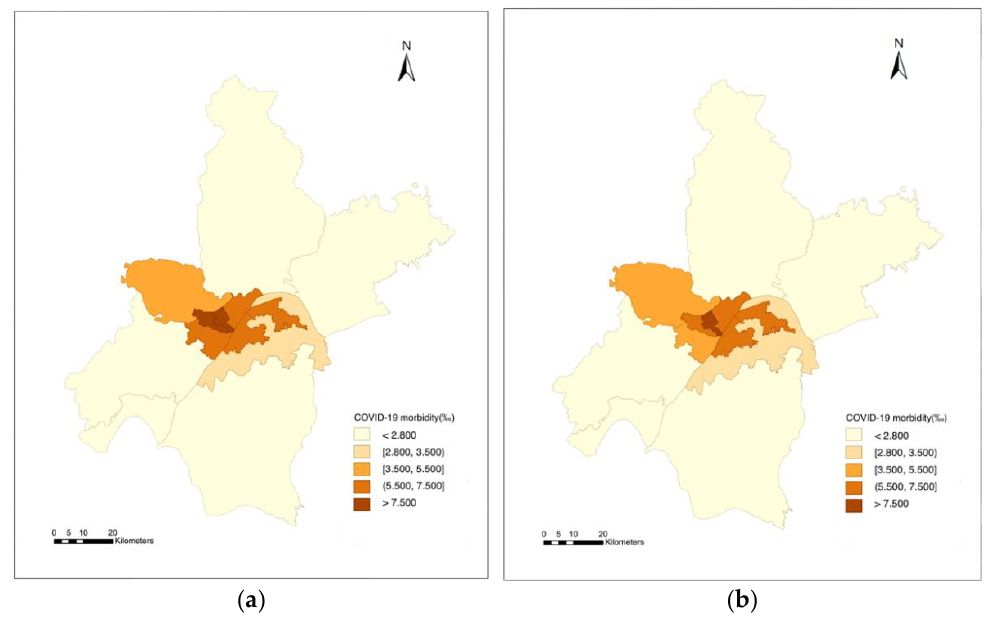
Figure 6. ( a ) Spatial distribution of COVID-19 morbidity rate in Wuhan. ( b ) Spatial distribution of SLM predicted value. Table 6. Summary statistics of OLS and SLM in modeling COVID-19 morbidity rate with the principal components.